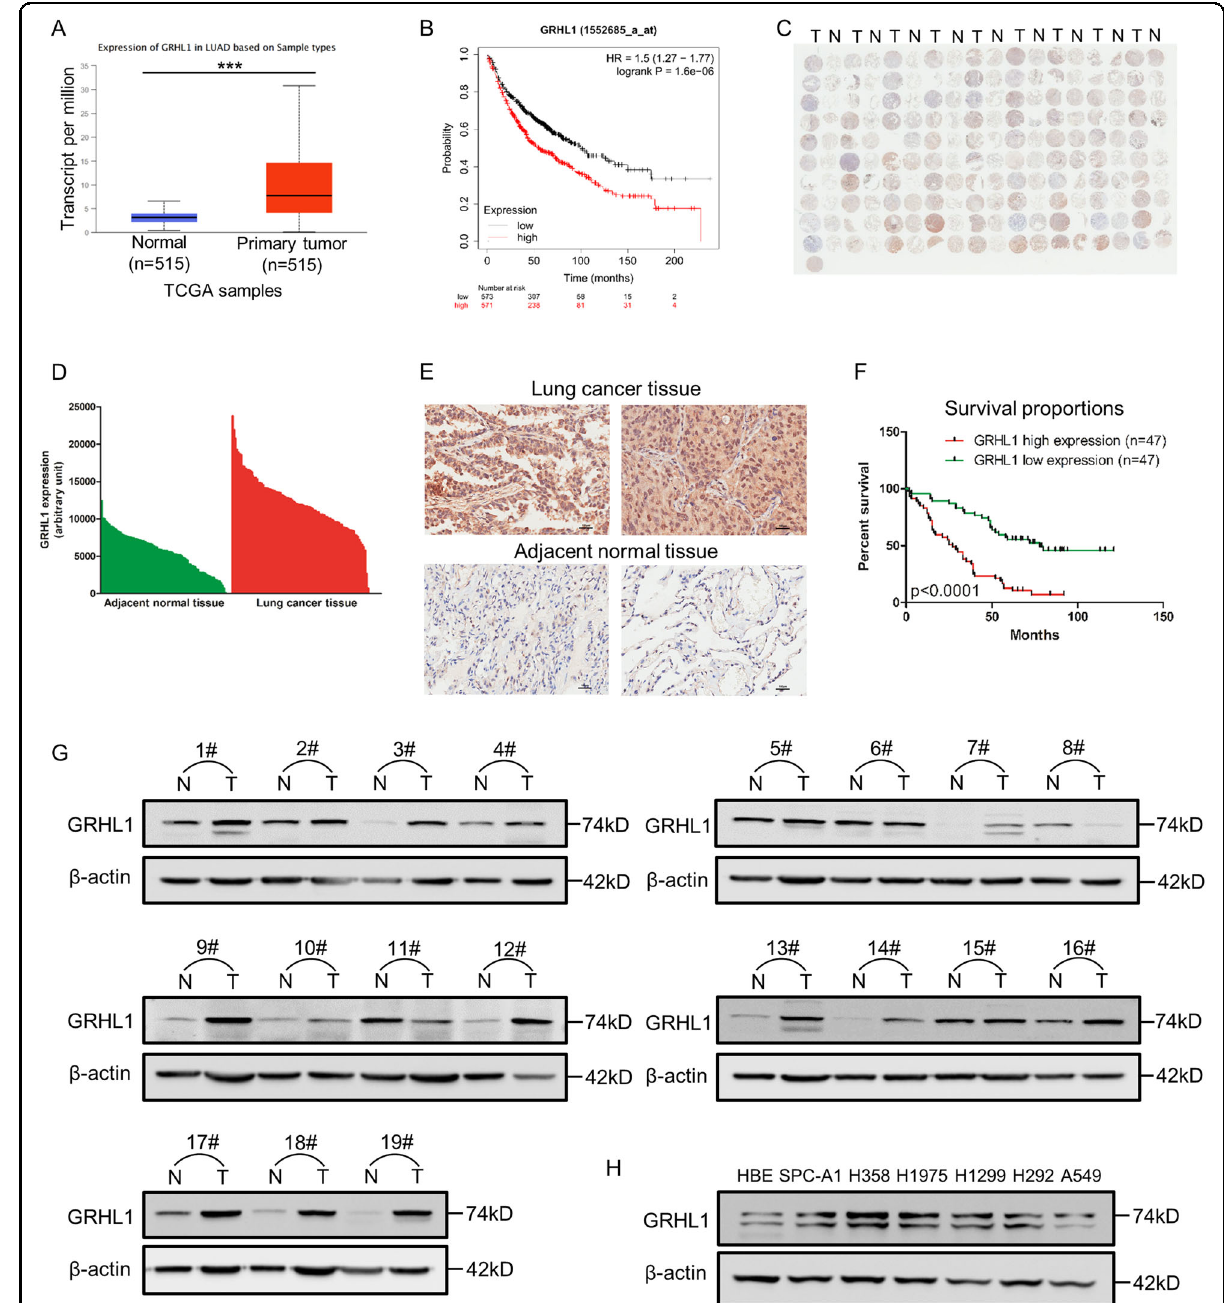
Fig. 1 GRHL1 is upregulated in NSCLC and closely related to the poor survival of NSCLC patients. A The mRNA levels of NSCLC samples (Normal and Primary tumor) were analyzed from TCGA using the following link: http://ualcan.path.uab.edu/cgi-bin/ualcan-res.pl. ***: P < 0.0001. B The overall survival curves of NSCLC patients were analyzed using Kaplan – Meier Plotter (https://kmplot.com/analysis/). C Immunohistochemical staining of a representative lung adenocarcinoma tissue microarray with an anti-GRHL1 antibody. T, tumor tissue; N, adjacent normal tissue. D Quanti fi cation of the immunohistochemical (IHC) staining shown in Fig. 1C. E Microscopic evaluation of IHC staining of two representative tumor tissues and adjacent normal tissues shown in Fig. 1C with an anti-GRHL1 antibody (brown) and hematoxylin counterstain (blue). Scale bars: 100 μ m. F Kaplan – Meier survival curve of 94 NSCLC patients. Patients were divided into two groups according to the average staining density of GRHL1 in cancer tissues of the tissue array (high expression: n = 47, low expression: n = 47, Log-rank (Mantel-Cox) test was used for the statistical analysis). G The protein expression levels of GRHL1 were determined by western blot using the paired, tumor-adjacent noncancerous lung tissues (normal, N) and human NSCLC tissues (tumor, T) from 19 NSCLC patients (1# − 19#). H The expression levels of GRHL1 in NSCLC cell lines (SPC-A1, H358, H1975, H1299, H292, A549) and HBE cells were examined by western blot using an anti-GRHL1